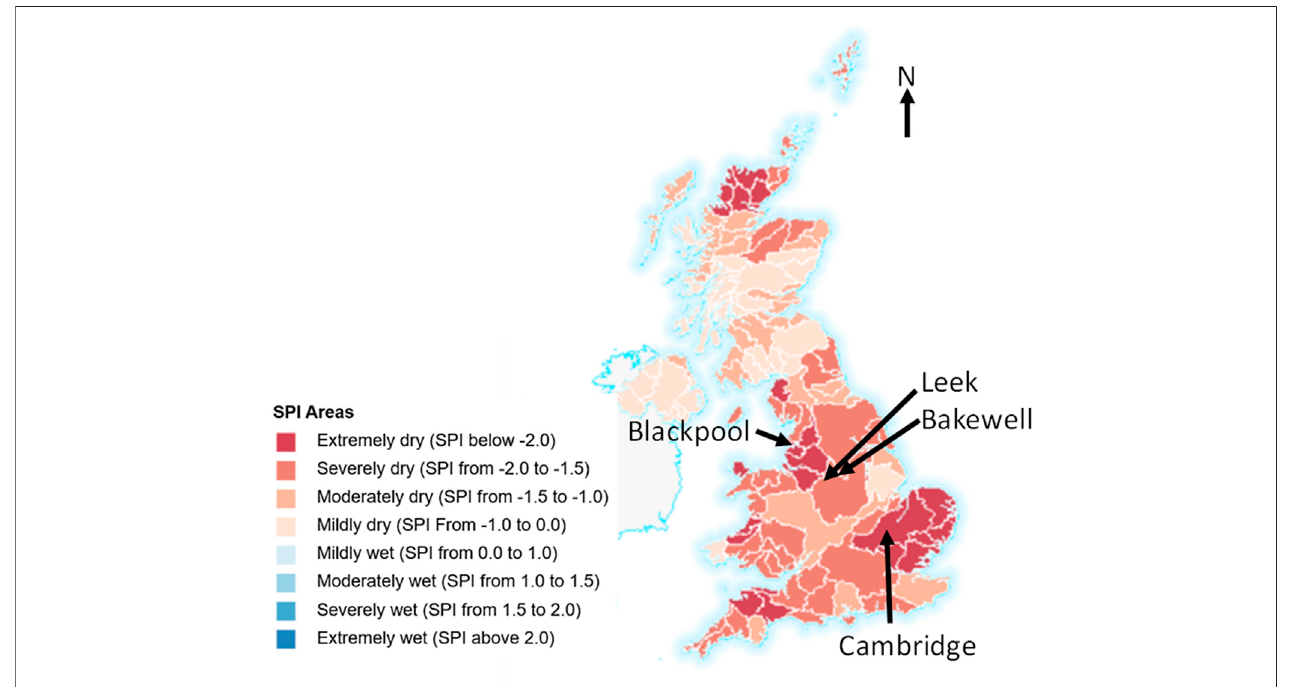
FIGURE 1 | Spatial distribution of the 3-month Standardized Precipitation Index (SPI) for river basins across the United Kingdom for the 3 month period ending in July 2018 (Source: UKCEH Drought Portal). The locations of towns mentioned in the paper are indicated.